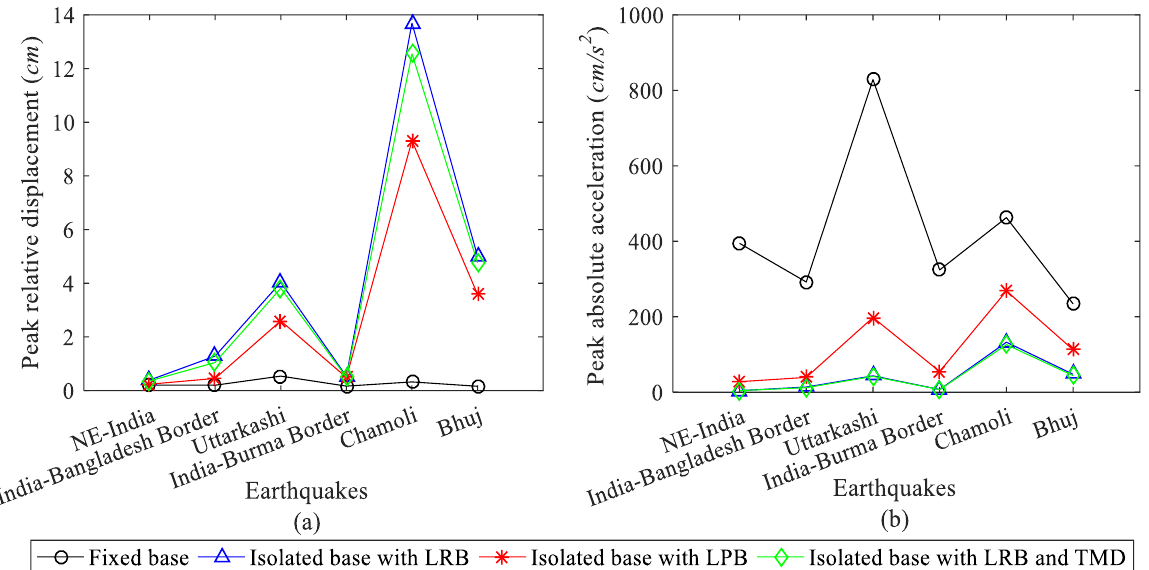
Fig. 16. (a) Roof peak relative displacement (b) Roof peak absolute acceleration of structures under earthquakes.